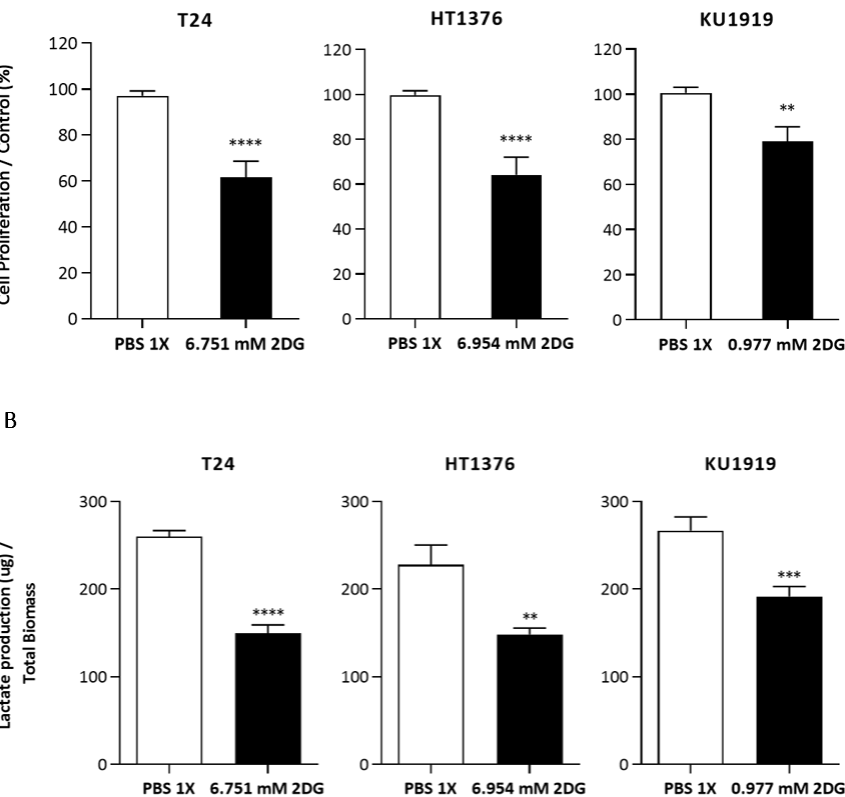
Figure 6. Effect of 2DG on the proliferation ( A ) and lactate production ( B ) of T24, HT1376, and KU1919 urothelial bladder carcinoma cell lines, detected by BrdU incorporation ( A ) assay and by a colorimetric kit ( B ) at 72 h post-treatment. Results are expressed as normalized means ± SEM of at least 3 independent experiments, each one in triplicate. ** p < 0.01, *** p < 0.001 and **** p < 0.0001 for 2DG IC 50 versus control condition (PBS 1×).